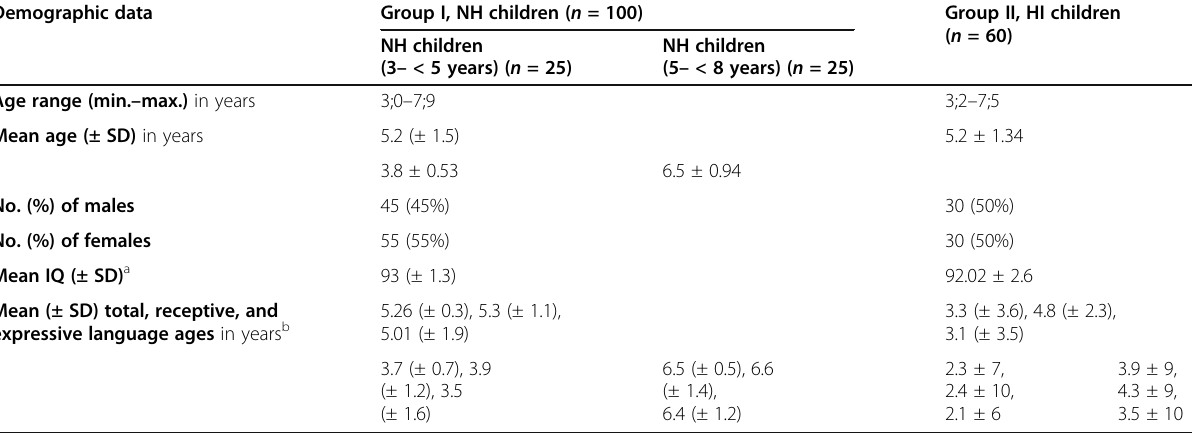
Table 1 The demographic data of the participated children Demographic data